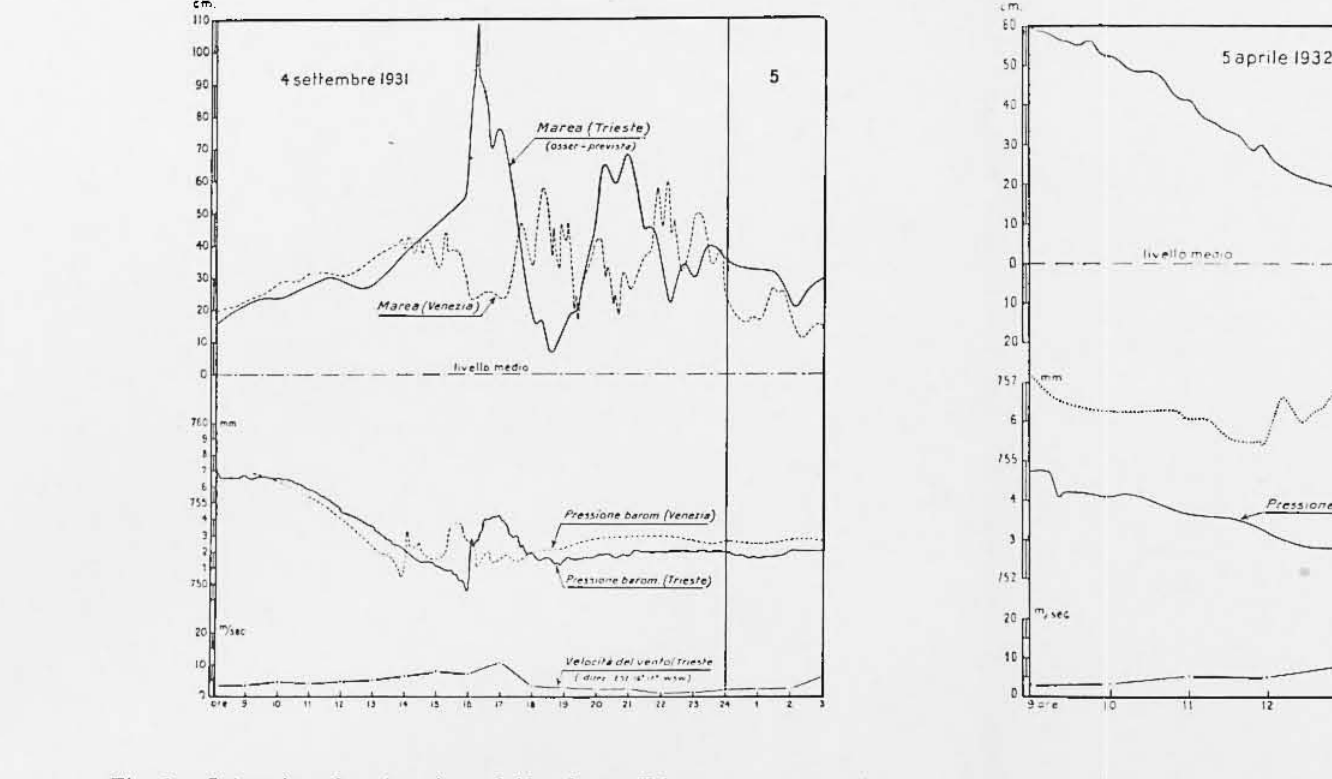
Fig. l - Interaziunc fra atmosfera (\(1 idrmlfel'fl fl Trieste, per prupagazione Pig. 2 _ Altru chiarissimo esempio di intemziune fra atmosfcra etI i(ll'oRfel'a di distul'llj micrubarici vcnlO la hase !lei g-olfo di Tl'iCfltC, cun velocit.à dell'ordine nel golfo di Trieste, particularmente pronunciato nei brevi periudi. Il disturbo di quella tlelle onde libere del maro sottostantc (2.5): oltre alla sessa del golfo mierobal'ico iniziale di circa 1/5 tli Torr, IJl'ovoca un balzo nell'acqua di ca. di TriCfltc (e Venezia), con periodo di 3h4:jnl ca, l'interazionc provoca ini zialmente un balzo !li livello di 52 cm SII breve periodo, in corrispondenza di un copcriollale diRhullQ microbal'ieo di solo mezzo TOlT: quindi, con un effett.o dinamico pari a ca. 87 volte quello stat.ico. Fig. l - Intcraction bctwecn atmospherc and hydrosphcrc in Triest.e, ùue Fig. 2 - AnothCI" eleaI" eviùencc of interact.ion betwcen atmosphel'c an!l Fig. 3 - In t.his e"Xample, too, t.hc !lxnami" etIed on ~hurt periu,ls is tu thc propagation or microbaric Iwrturlmtiom\ towal'll the Gulf of TrieRte, hy~lrosphcrc in the Gulf of TrieRte, particularly strong in the short pcriodl!. at a vclocity in thc ortIer ui that of the frce wavCfl of thc unùedying sca (" ~): The initial microbarie pel'turbance of abuut 1/5 Tun causes the watcr to the intcraction gives rise not only to the Rciche uf the Gulf of TI"icstc (and buuntI some 40 cms; in othcr terms, the dynaillic etlect. is abuut 1:;0 times Venice), with periuùs of allout 3 hours and 45 minutes, llut initiallyalso to a./; strong al! the st.atic effect.. a bound of :;2 cms of the level on a short ]Jeriud, COITtlslJOnding to a micrubarie cuperiodal perhullation of only 1/2 ToI'!': thei'Cfol'l1 with a dynamic effect. equal tu 87 times the static effcct.